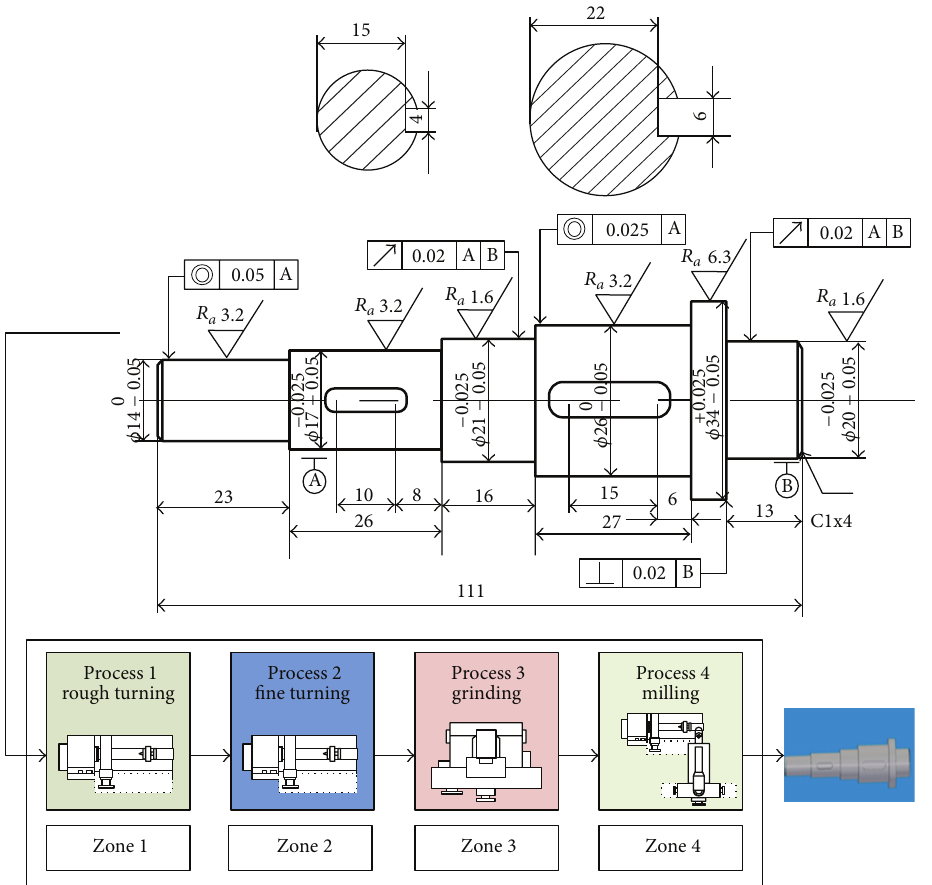
Figure 4: The existing process plan for the axis.